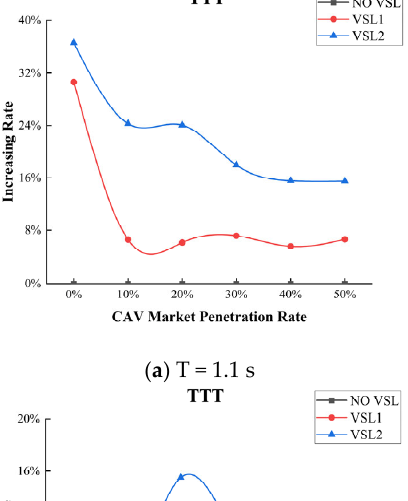
Figure 5. Safety results of VSL control strategies.